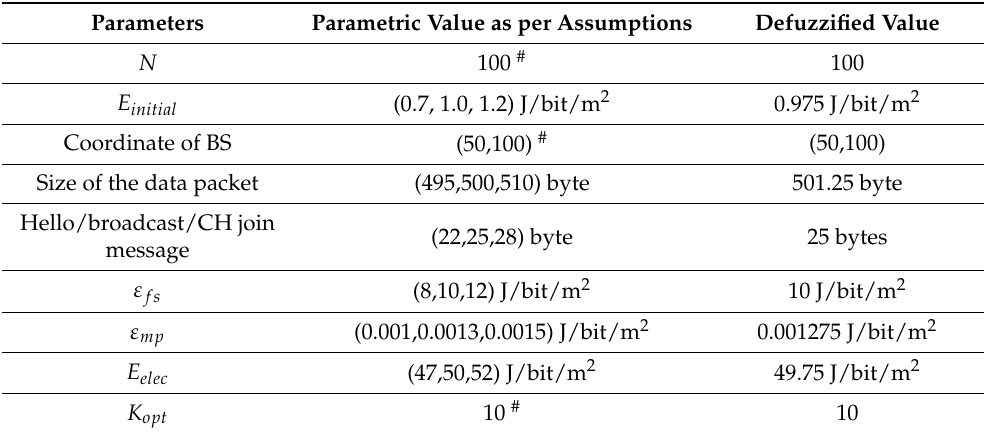
Figure 3. Distribution of 100 nodes around the Table 4. Values considering different simulation